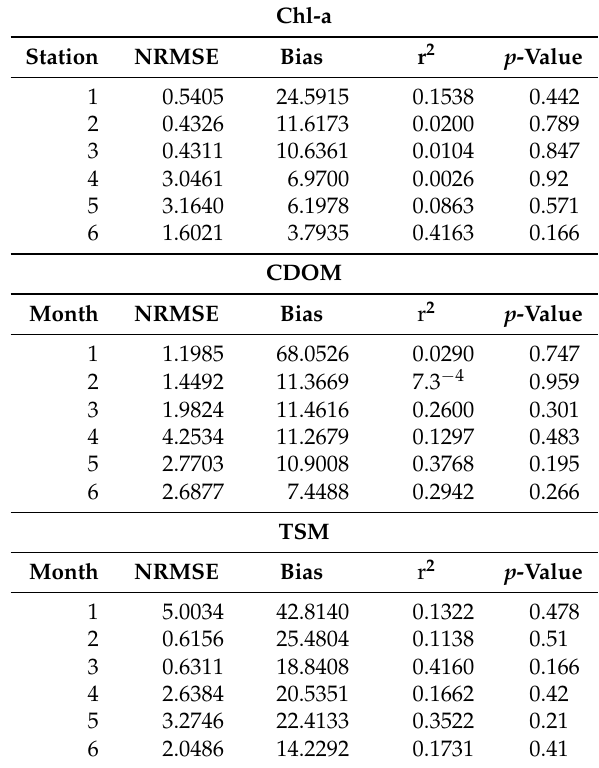
Table 4. Validation results: summary of the computed measures for the water quality parameters for every